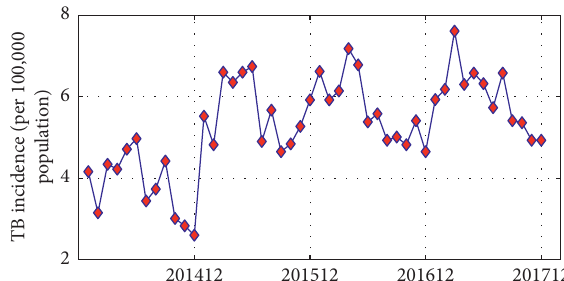
Figure 2: The TB incidences in Urumqi from January 2014 to December